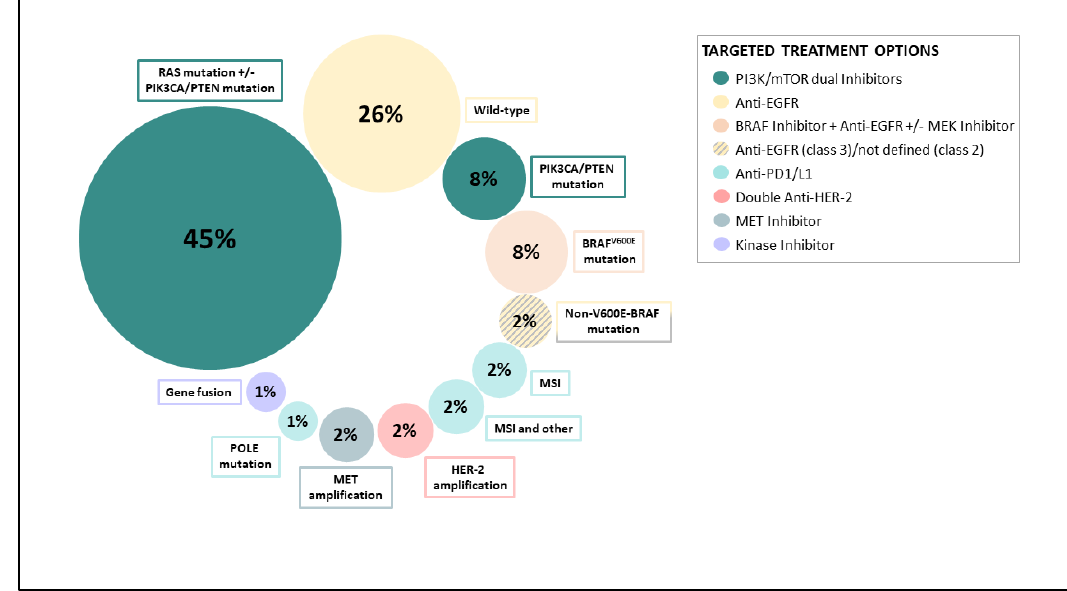
Figure 2. Most frequent genetic subtypes observed in mCRC and potential targeted treatment options (adapted from [52]), © Silvia